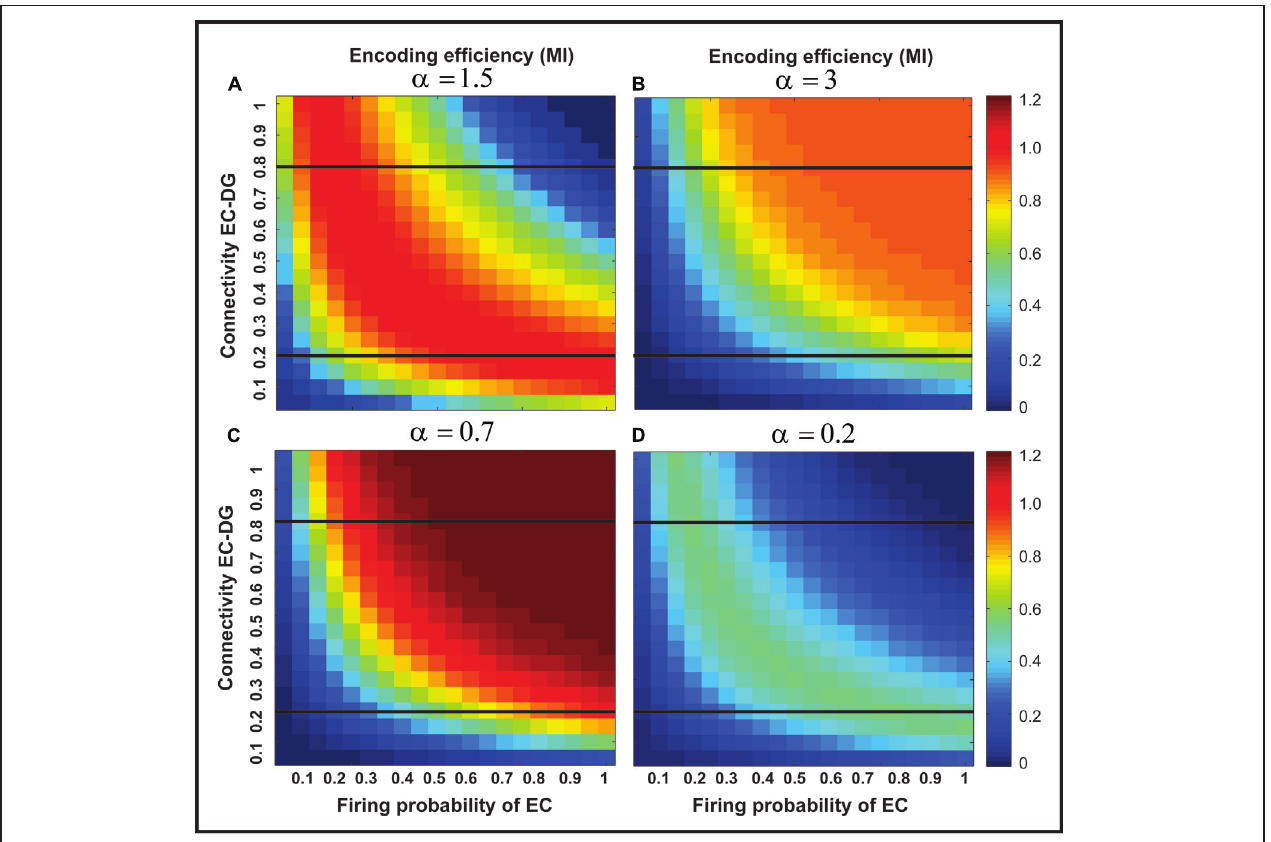
FIGURE 5 | The effect of feedback inhibition on mutual information. Mutual information as single neuron’s encoding efficiency for all connectivity rates and firing probability depends on the feedback inhibition parameter value. A decrease in